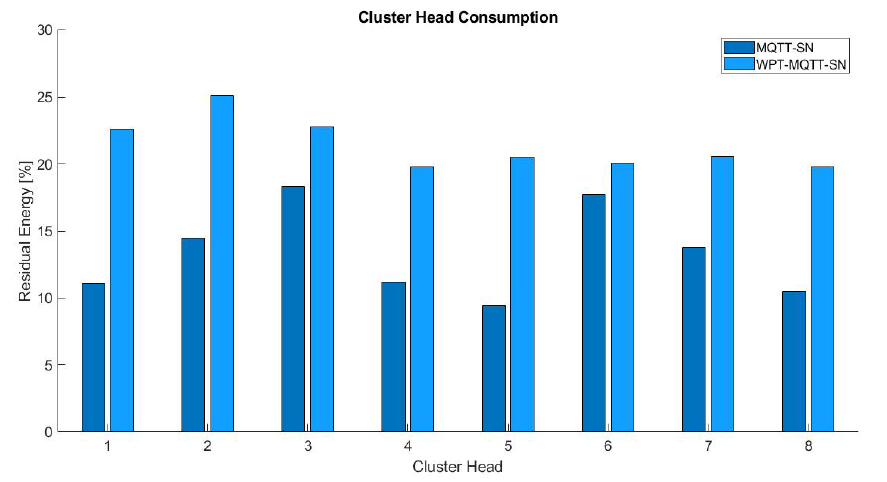
Figure 9. Cluster Head Energy Comparison in Balanced Random Mesh